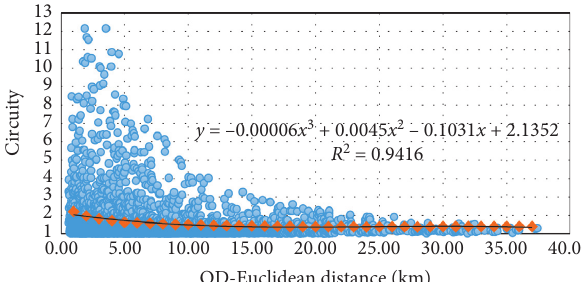
Figure 5: OD-Euclidean distances and circuity distribution.